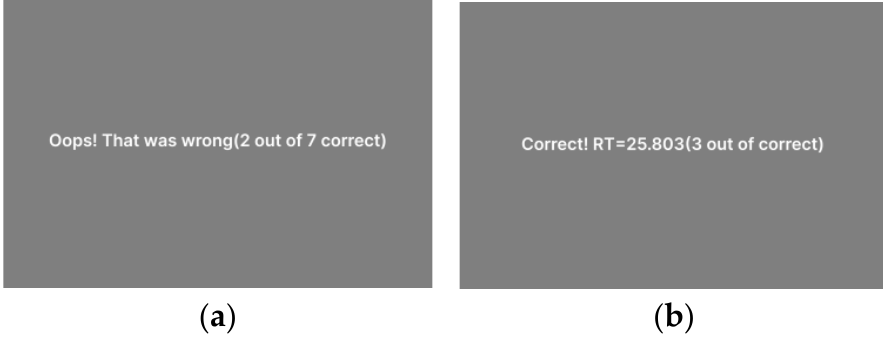
Figure 9. Answer error feedback ( a ) and correct answer feedback ( b ).